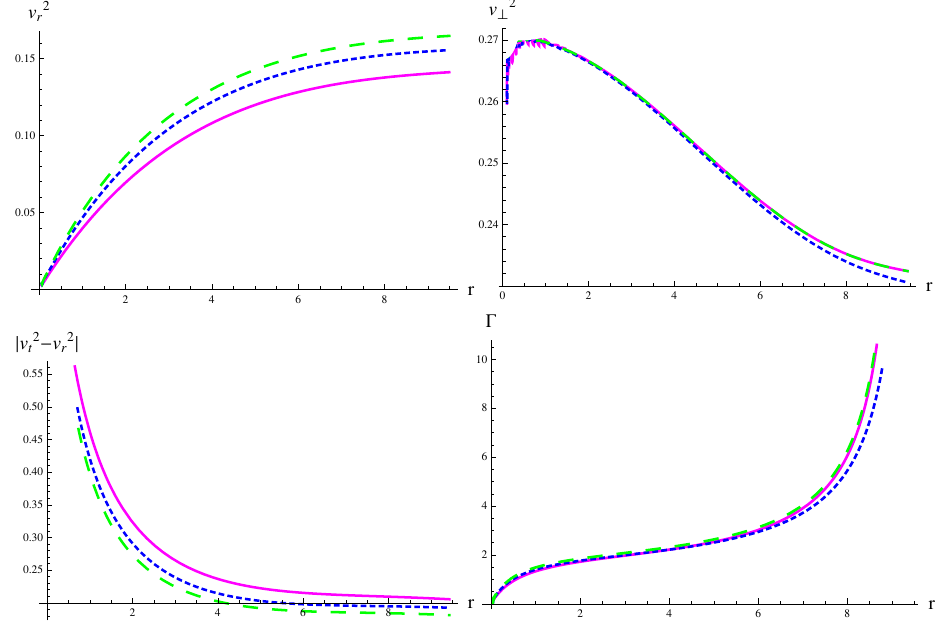
Figure 8. Plots of radial/tangential velocities, | v 2 ⊥ − v 2 r | and adiabatic index of extended solution I for Υ =